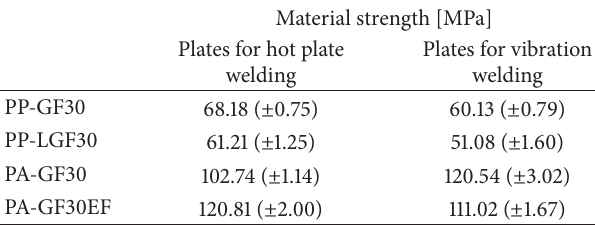
Table 7: Material strength.